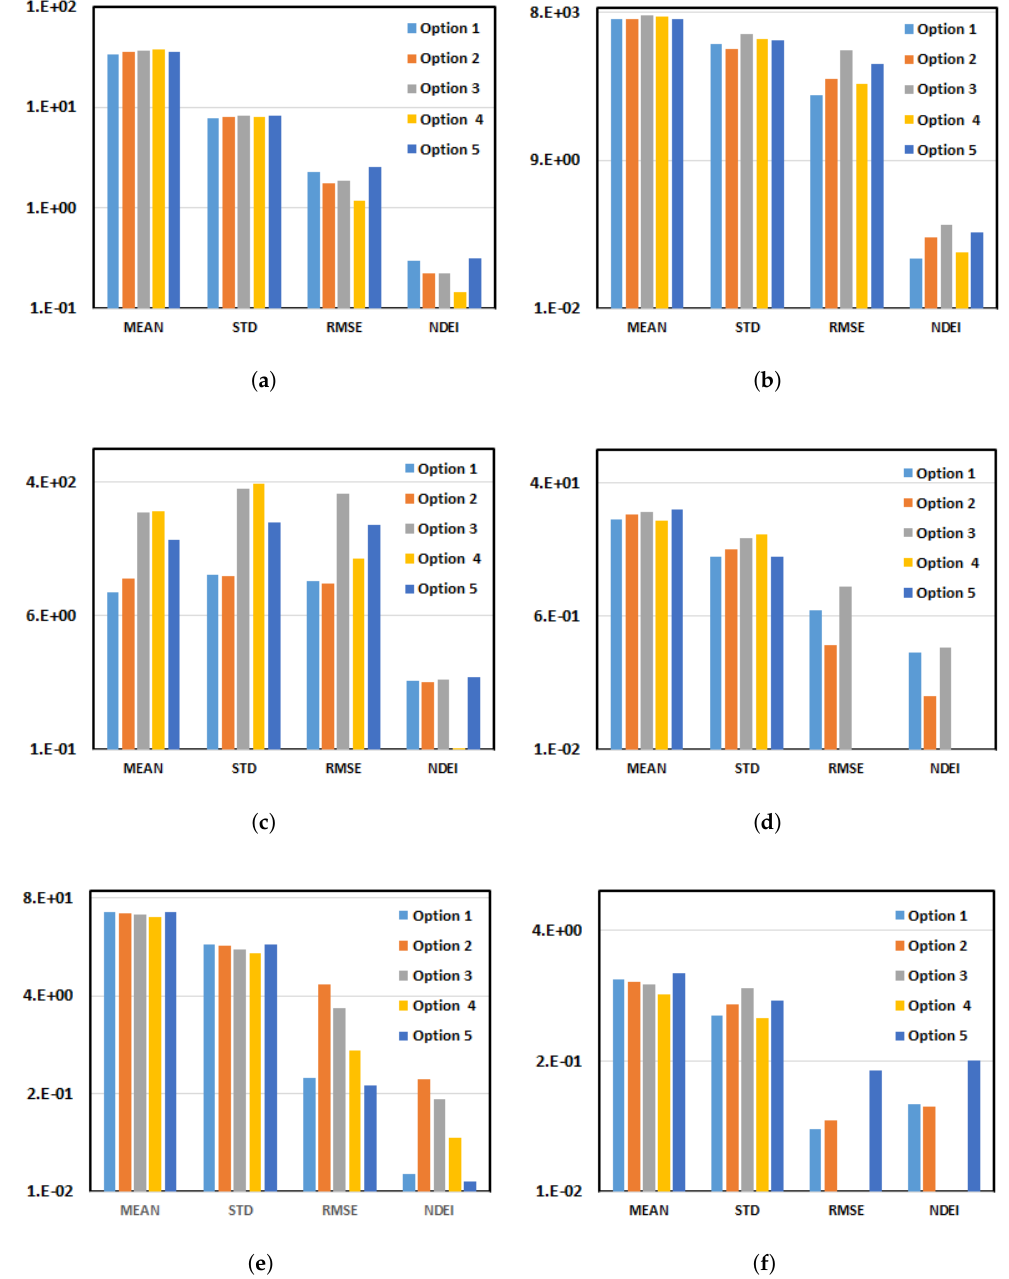
Figure A2. Statistical data plots of worldwide successful CO 2 injection EOR projects for the variables: ( a ) API; ( b ) depth; ( c ) permeability; ( d ) porosity; ( e ) saturation; and ( f )